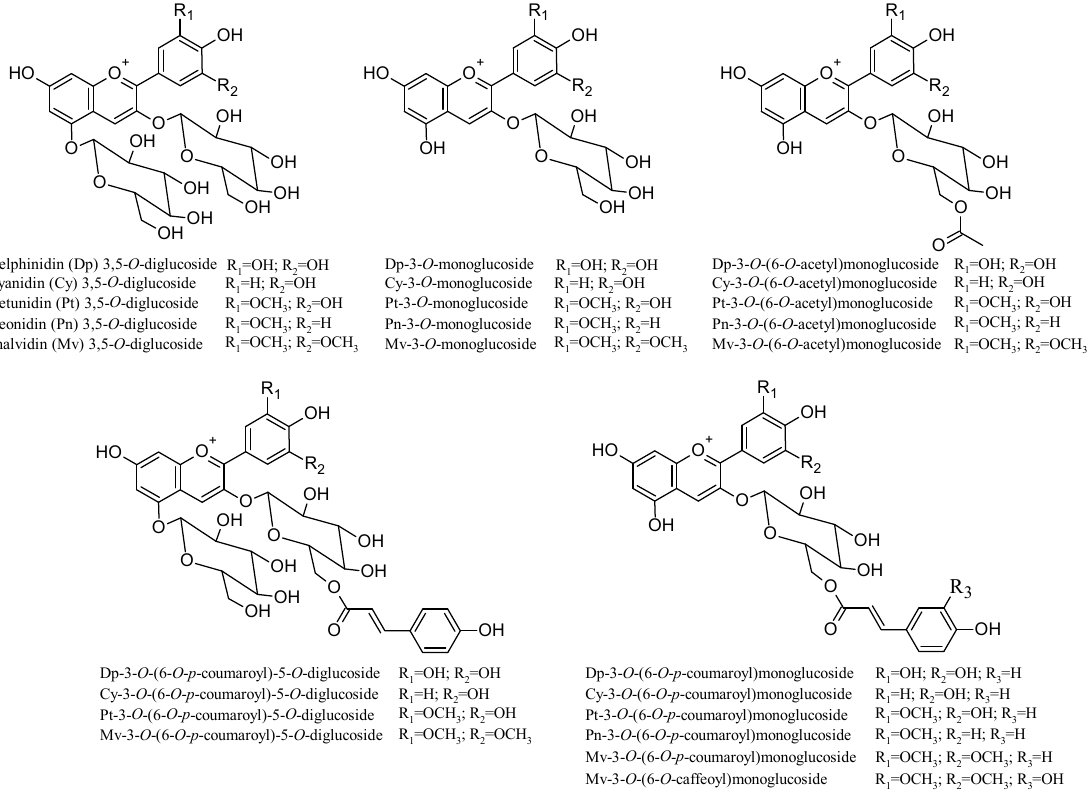
Figure 4. Structures of anthocyanins identified in 21 different hybrid red grape varieties.